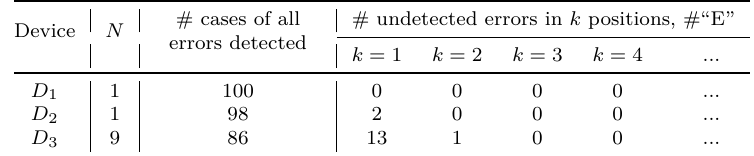
Table 10: Empirical distribution of errors in the ECC-based key recovery attack based on [8 , 4 , 4] 2 extended Hamming code (100 trials).